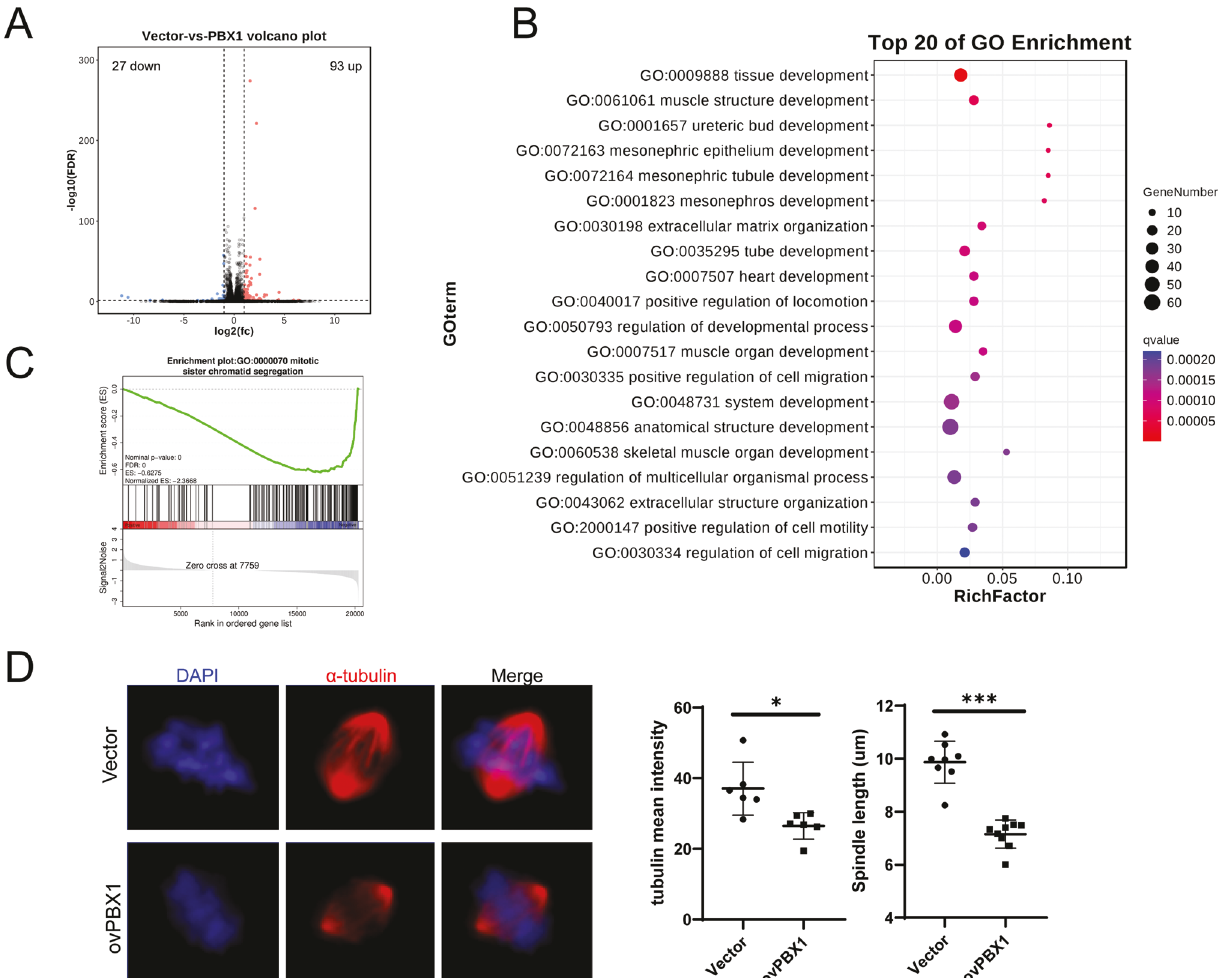
Fig. 4 PBX1 suppressed spindle function in CRC cells. A The volcano plot showed the differential expression genes between PBX1 overexpression and negative control HCT116 cells according to RNA-seq. B The GO enrichment analysis on differentially expressed genes in PBX1 overexpression cells. C GSEA analysis con fi rmed PBX1 inhibited mitotic sister chromatid segregation pathway in CRC cells. D Immuno fl uorescence image showing the spindle in PBX1 overexpression and negative control HCT116 cells. The fl uorescence intensity and length of spindle tubulin were measured,